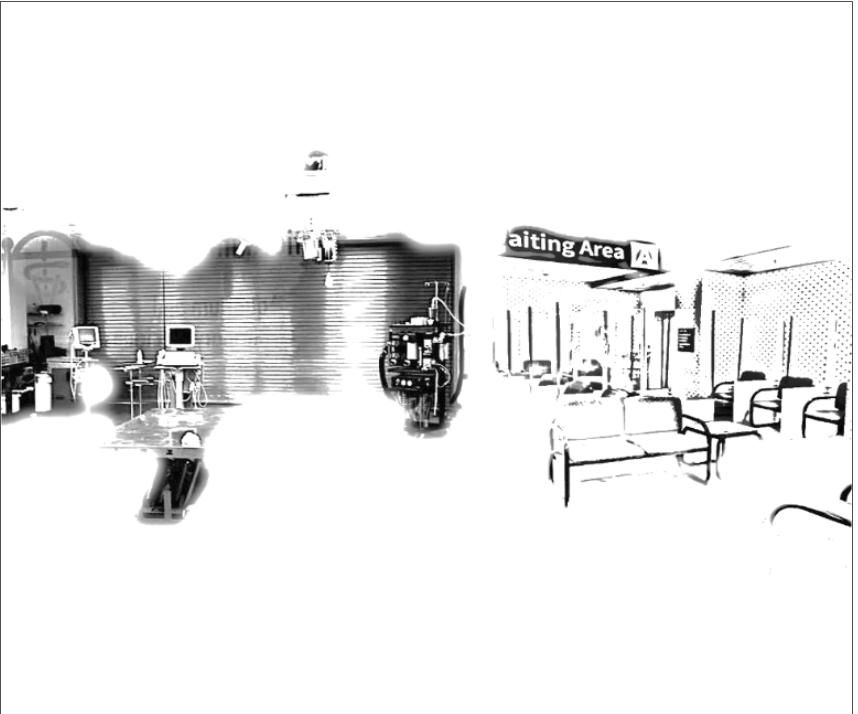
Figure 2 . Where is the